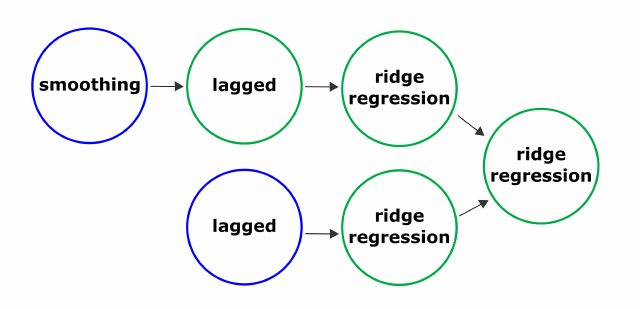
Figure 6. Example of generated pipeline with operation names in the